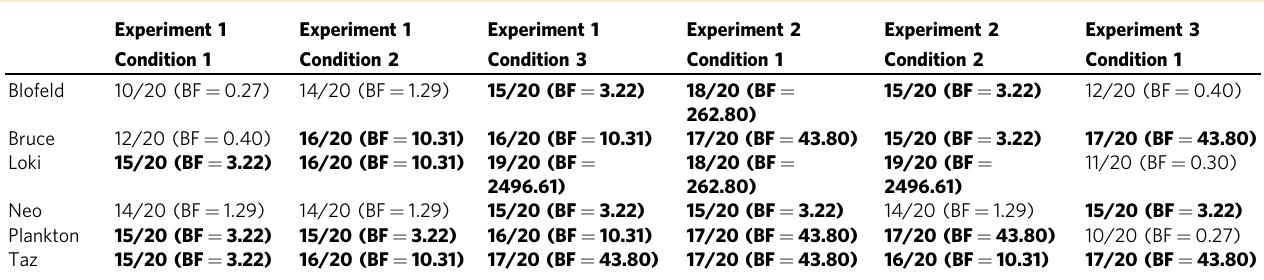
Table 1 Individual performance in experiments 1 – 3.